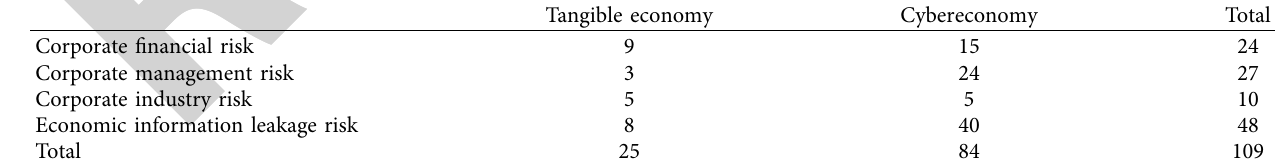
Figure 7: Comparison chart of economic risk prediction. Table 2: The number of forecasted events for real economic risks and network economic